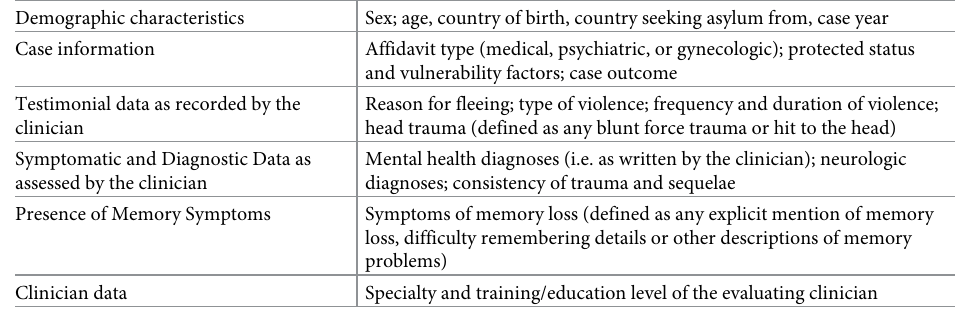
Table 1. Coding manual codes. Demographic